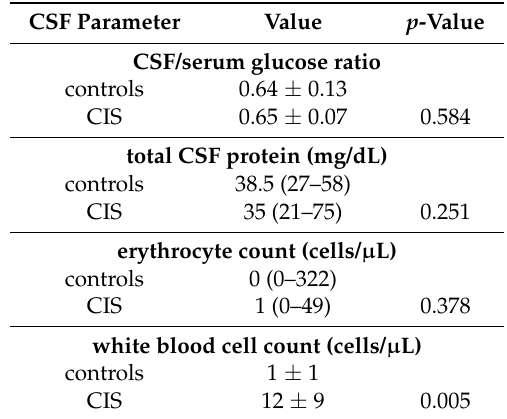
Table 1. Cerebrospinal fluid (CSF) characteristics of control- and clinically isolated syndrome